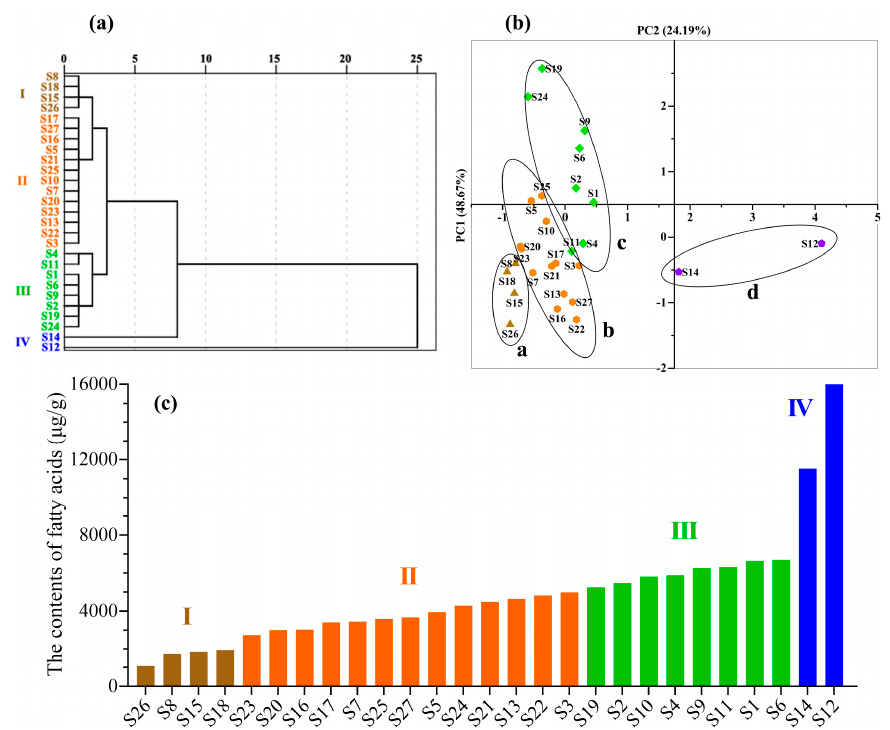
Figure 9. Unsupervised pattern recognition model of chemometrics. ( a ) The result of HCA of 27 batches of Oviductus Ranae , ( b ) PCA score chart of 27 batches of Oviductus Ranae in the first two principal components (PCs), and ( c ) The order of total content of six PUFAs in 27 batches of Oviductus Ranae .